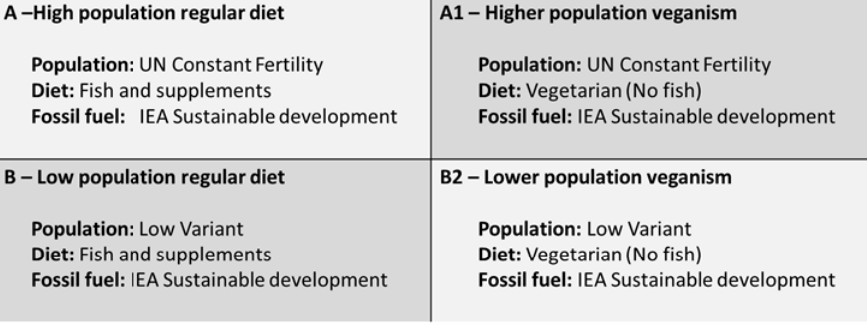
Figure 4. Analyzed frameworks for C. cohnii supply (higher-end needs).